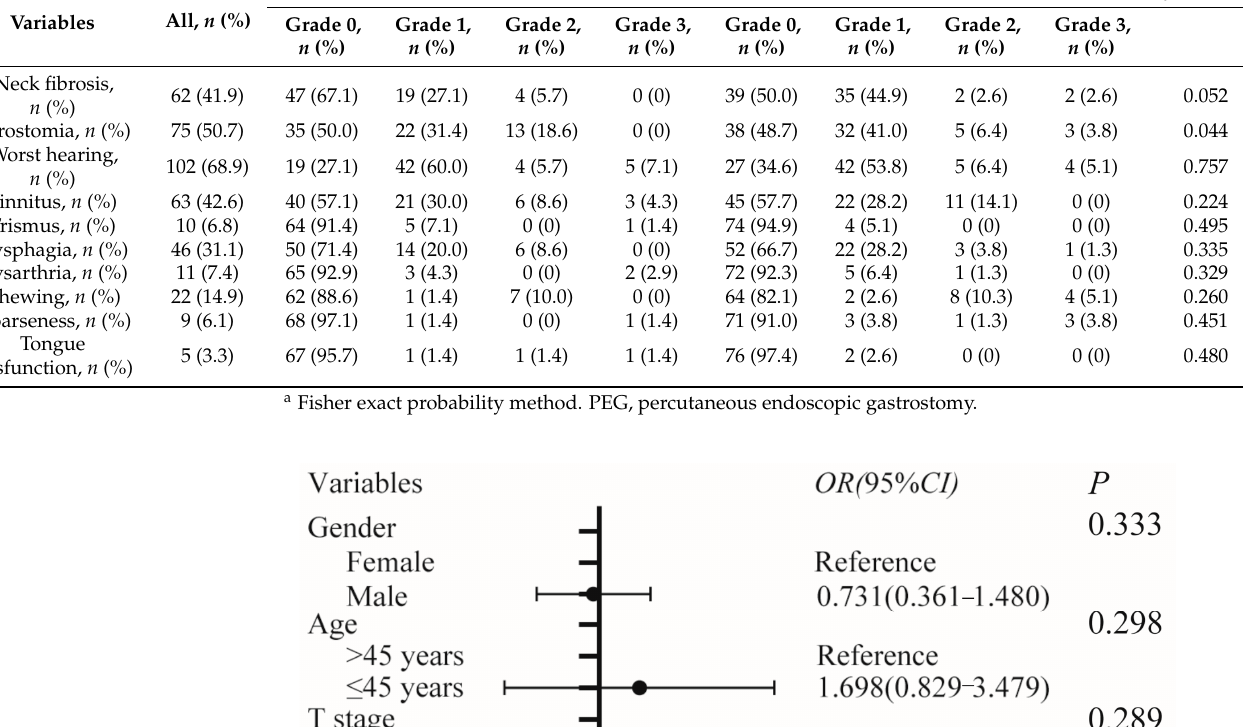
Table 2. Comparison of late toxicities between non-PEG and PEG groups.